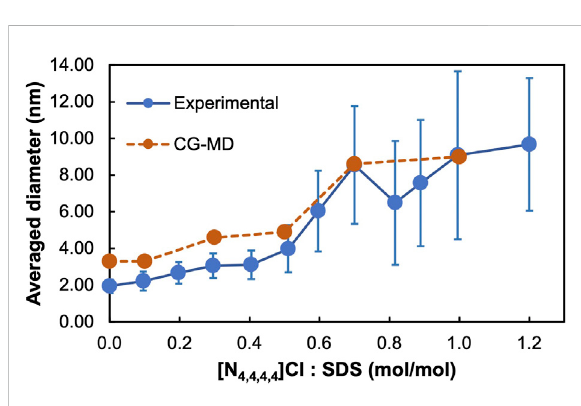
FIGURE 3 Experimental and CG-MD aggregate size distribution for the [N 4,4,4,4 ] + /[DS] - molar ratios shown in Figure 2. DLS was used to obtain the experimental data where additional [N 4,4,4,4 ] + /[DS] - molar ratios were measured. Bars in the experimental data correspond to half the base peak distribution and not the standard